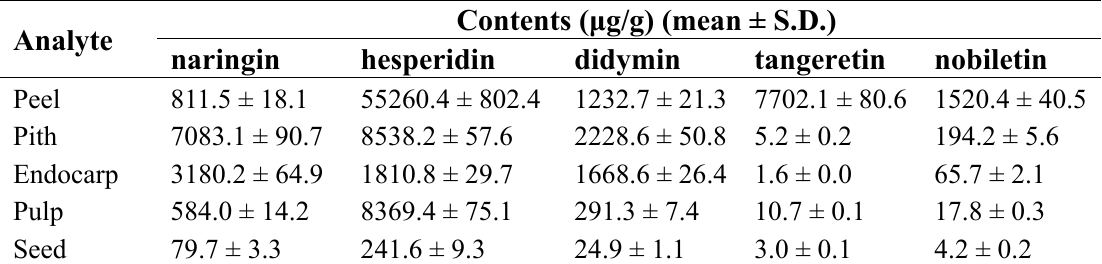
Table 3. Amount of five flavonoids in C. reticulata ‘Chachi’ Fruit ( n = 3).